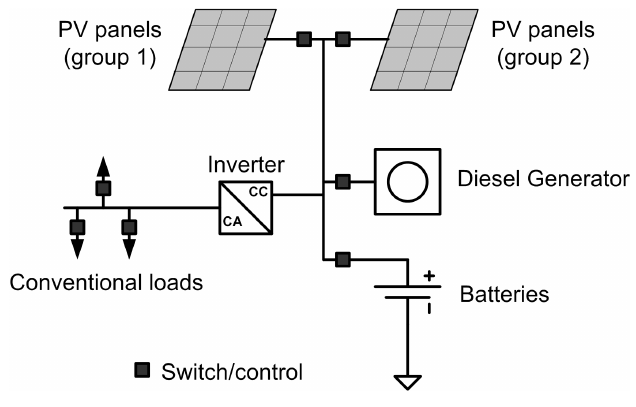
Figure 3. Basic architecture of an FSA.